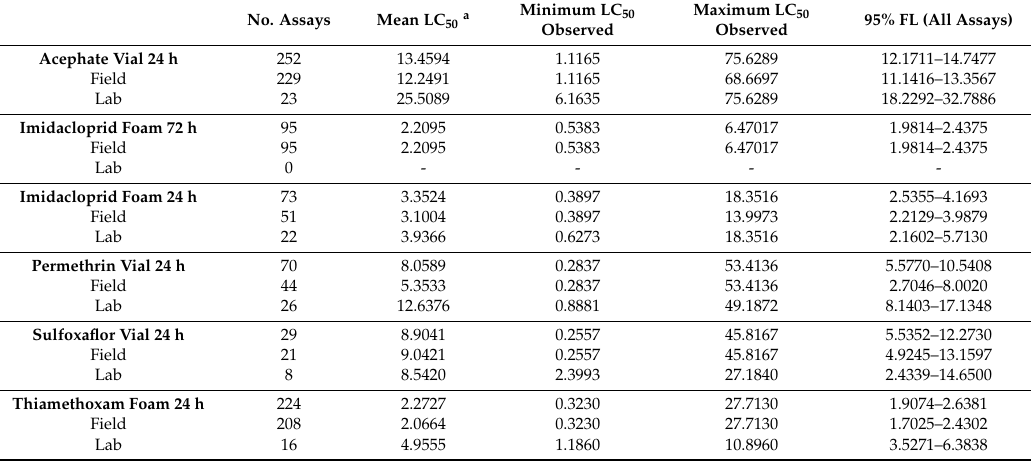
Table 2. Summary statistics of bioassays (2008–2015) conducted to measure susceptibility of tarnished plant bug populations in the Mississippi Delta to acephate, imidacloprid, permethrin, sulfoxaflor, and